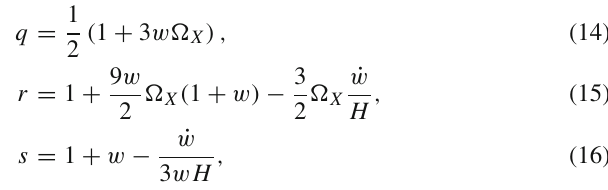
Fig. 4 This figure displays the evolution of statefinder pairs { r , s } , { r , q } and Om ( z ) for n > 1 and different values of α as Red (n = 2 , α = 4), Green (n = 2 , α = 6), Blue (n = 3 , α = 4) and Purple ( n = 3 ,α = 6). In the left panel, fixed point ( r = 1 , s = 0 ) denotes (cid:2) CDM. All trajectories in r − s plane pass through (cid:2) CDM. In the middle panel, the fixed points ( r = 1 , q = 0 . 5 ) and ( r = 1 , q = − 1 ) represent SCDM and dS. All trajectories in r − q plane diverge from